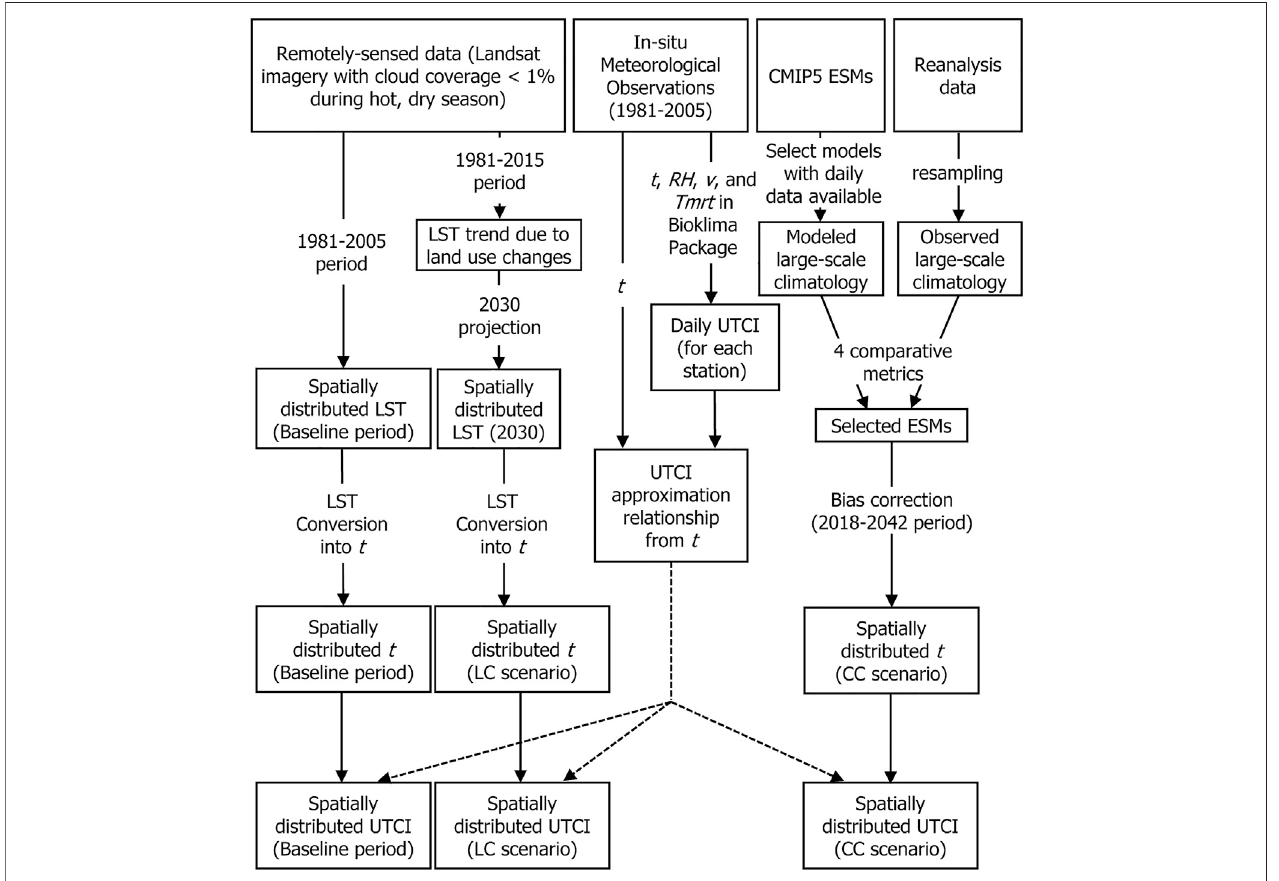
FIGURE 4 | Computation of the UTCI for the baseline period, the LC scenario, and the CC scenario.